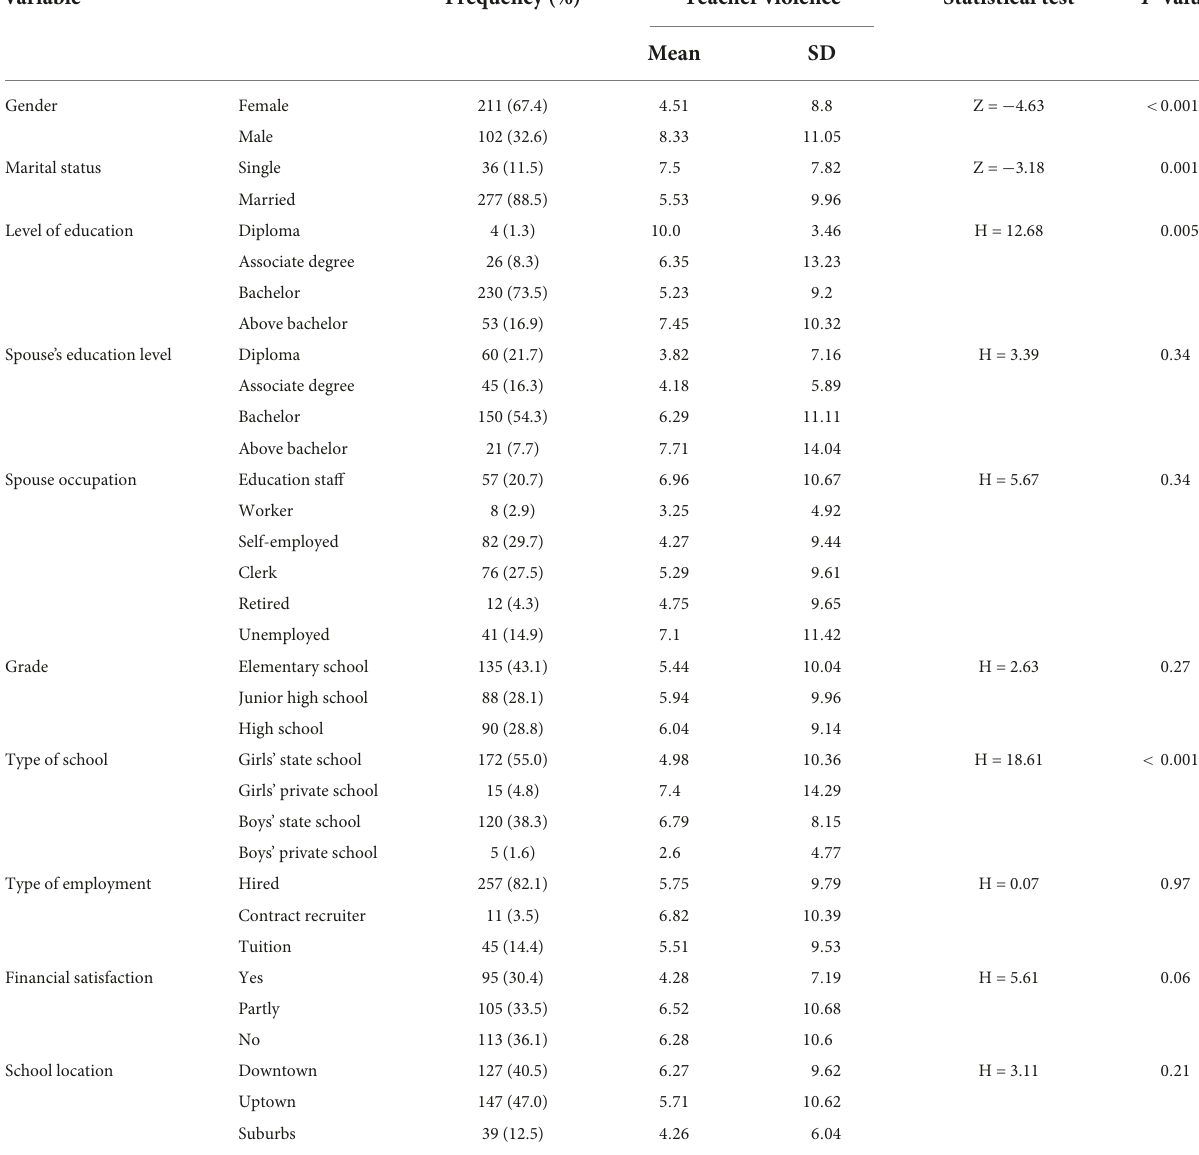
TABLE 1 The relationship between characteristics of teachers and teacher violence.